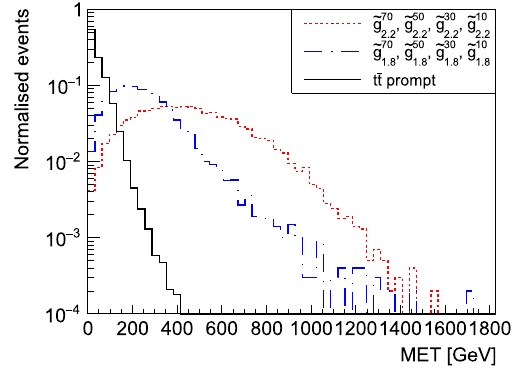
Fig. 70 Multiplicity of displaced tracks for each displaced top quark decay vertex for a gluino mass of 1.8 TeV and 2.2 TeV